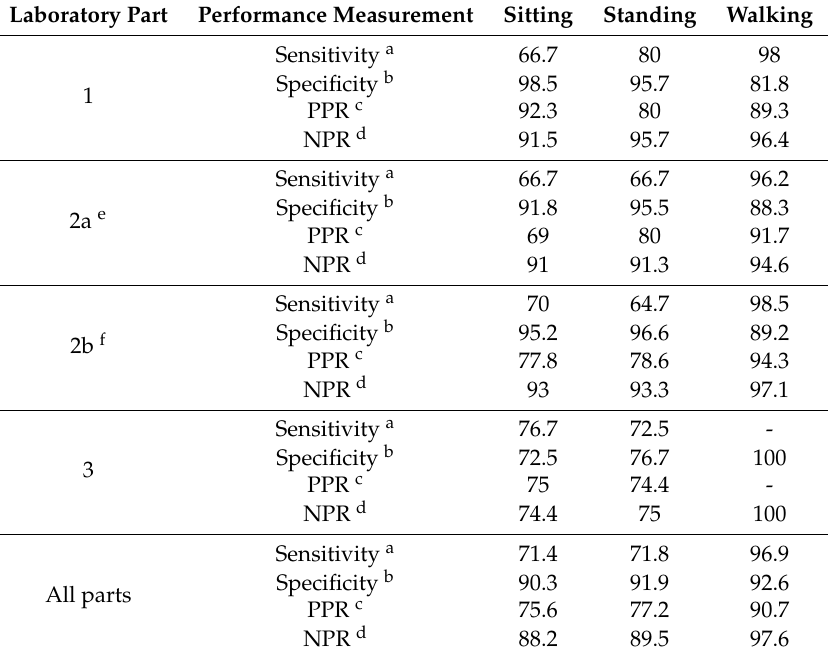
Table A2. Sub-study: performance of the VitaBit with ActiGraph as criterion